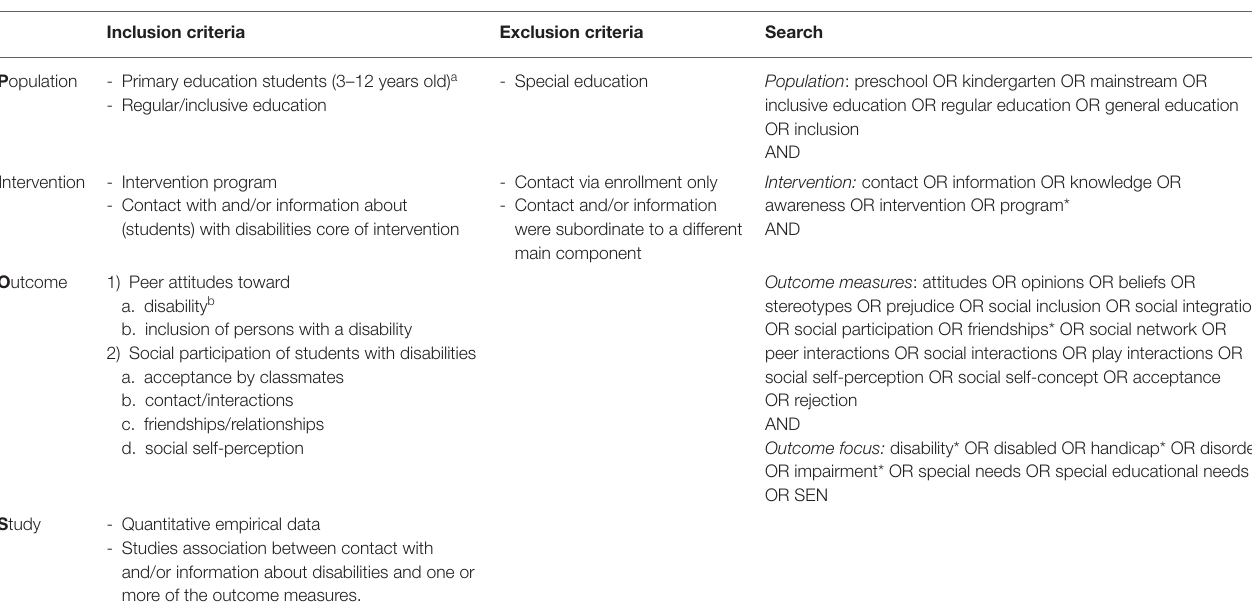
TABLE 1 | PICOS model of eligibility